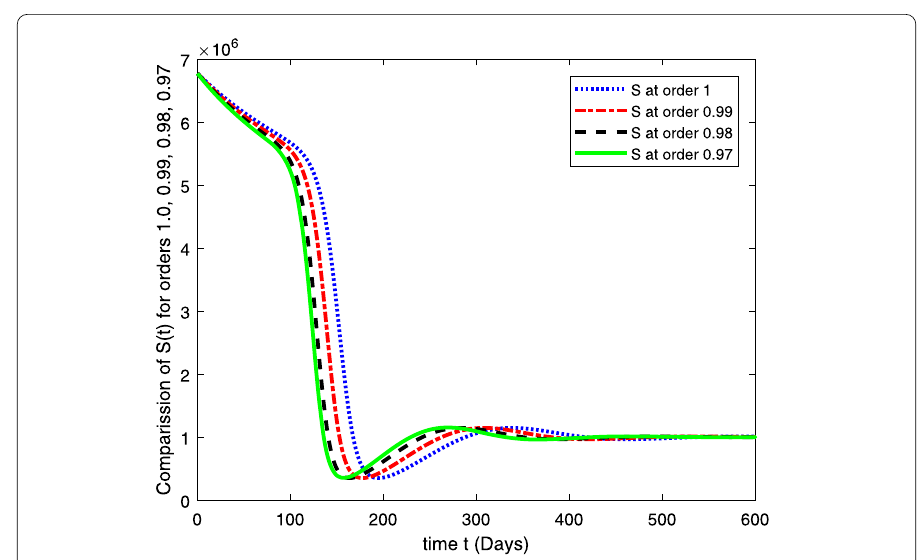
Figure 5 Computational results for S ( t ) while the fractional orders are 1.0, 0.99, 0.98, 0.97